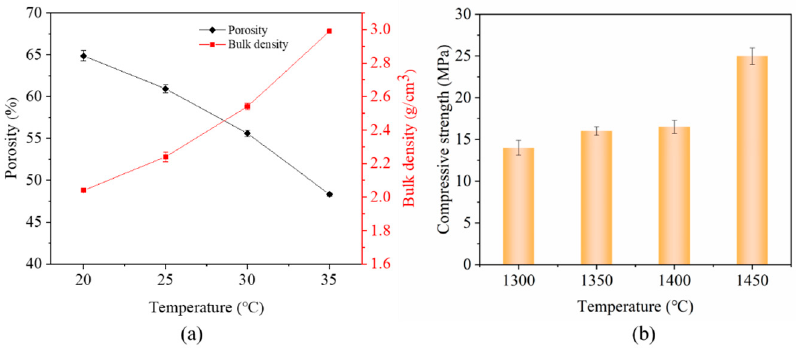
Figure 5. ( a ) Apparent porosity and bulk density of porous BCZT piezoelectric ceramics at different sintering temperatures, ( b ) compressive strength of porous BCZT piezoelectric ceramics at different sintering temperatures.